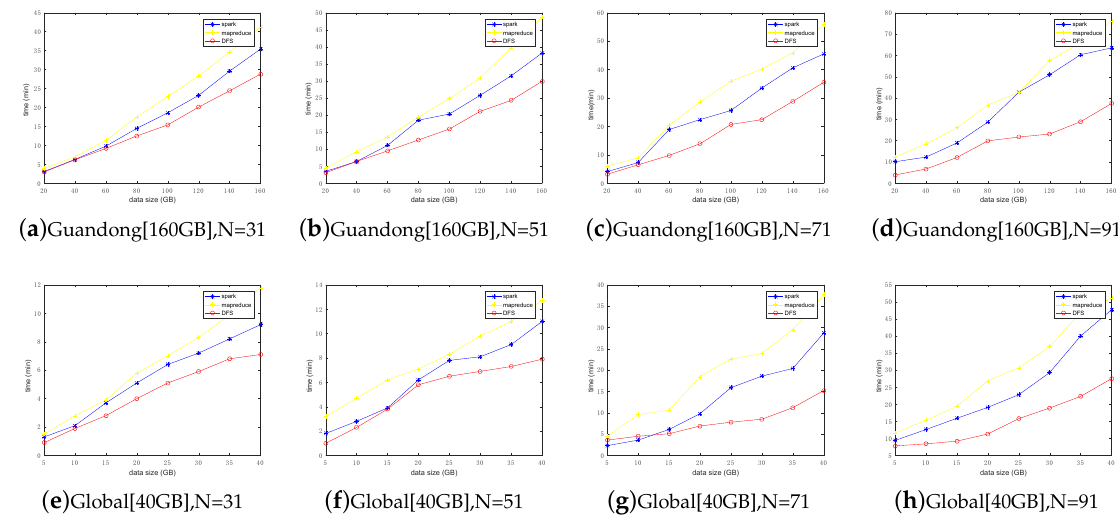
Figure 13. Comparison of timeliness of different frameworks. It can be seen that DFS has better performance advantages than other frameworks when there are more data. With the increase of N , the number of calculation cycles increased, and the performance advantage of DFS became more